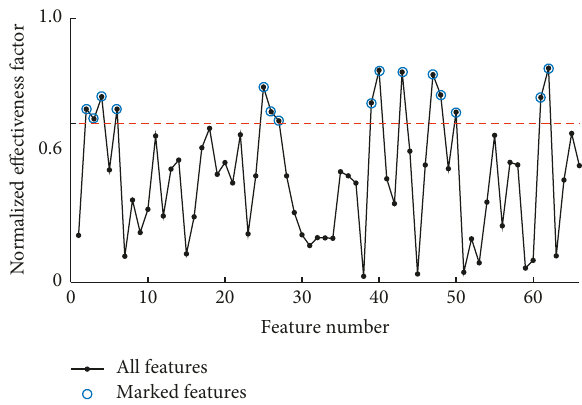
Figure 19: The marked features of IMFs components derived from VMD decomposition.